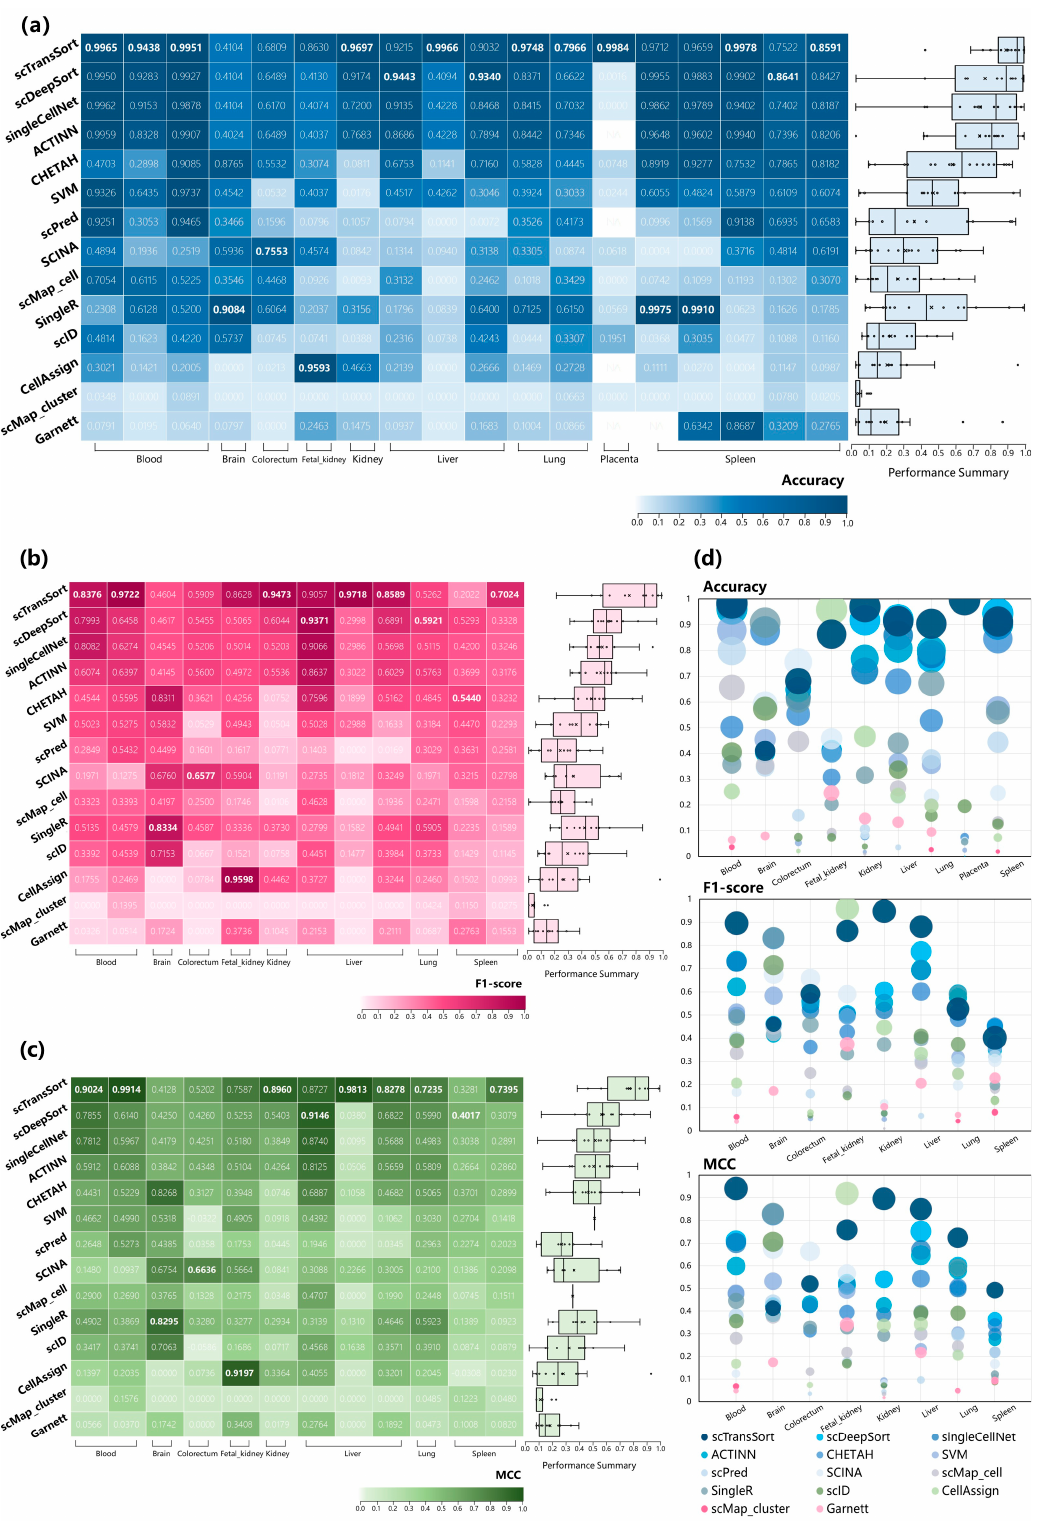
Figure 4. Performance comparison of scTransSort on human external test datasets (accessed on 1 June 2022). ( a ) Heat maps and boxplots of accuracy comparison for different methods on 18 datasets from 9 tissues; ( b ) Heat maps and boxplots of the mean F1 score comparison; ( c ) Heat maps and boxplots of the mean MCC comparison. The bolded font indicates the top-ranked method for each dataset; ( d ) The bubble charts summarize the accuracy, mean F1 score, and mean MCC of the different methods in each